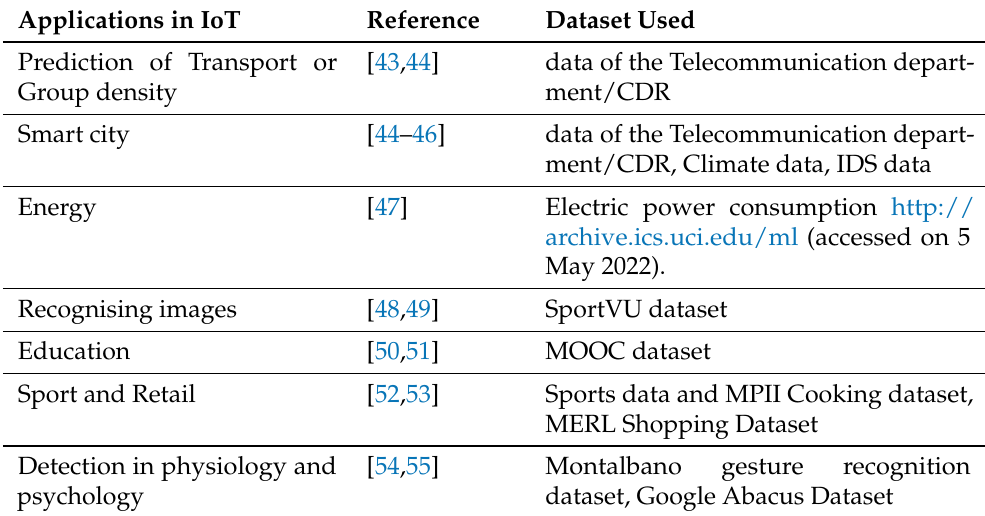
Table 1. RNN model in IoT